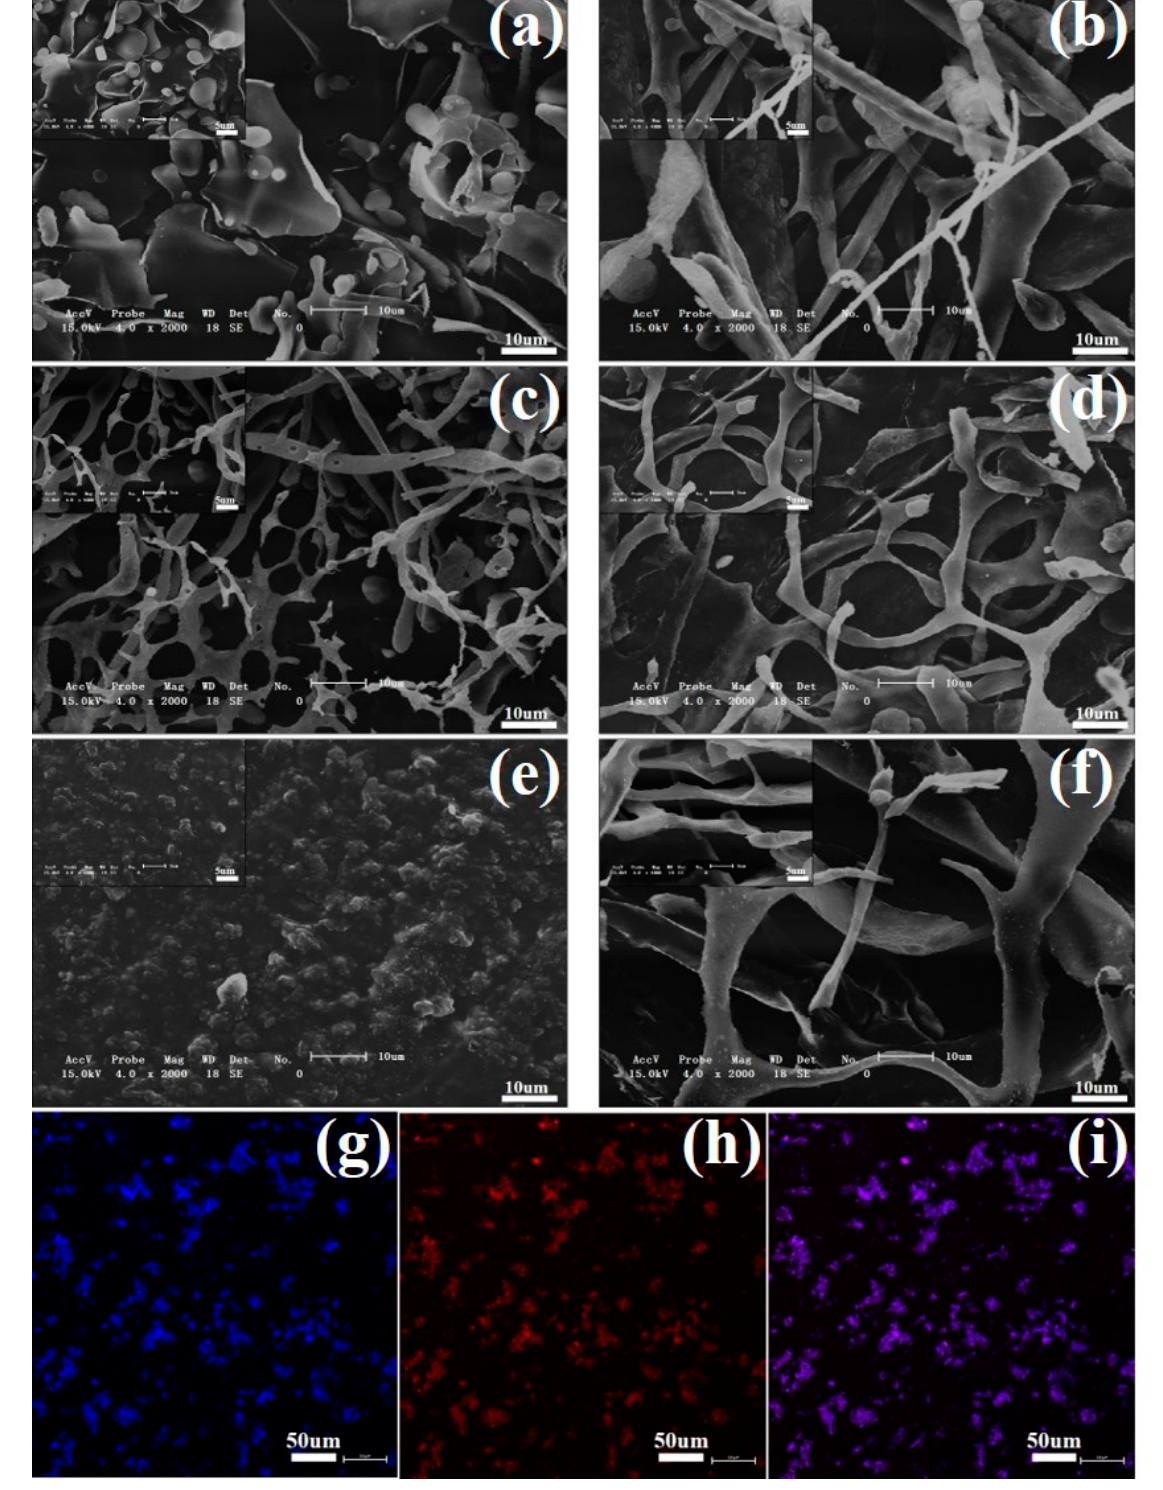
Figure 7. SEM images ( a – f ) and confocal laser images ( g – i ) of di ff erent raw materials and com- pounds. ( a ). SPI; ( b ). TFP-SPI; ( c ). HWP; ( d ). TFP-HWP; ( e ). TA; f . TFP-TA; ( g ). TFP staining image; ( h ). SPI staining image; ( i ). TFP-SPI solution staining image.